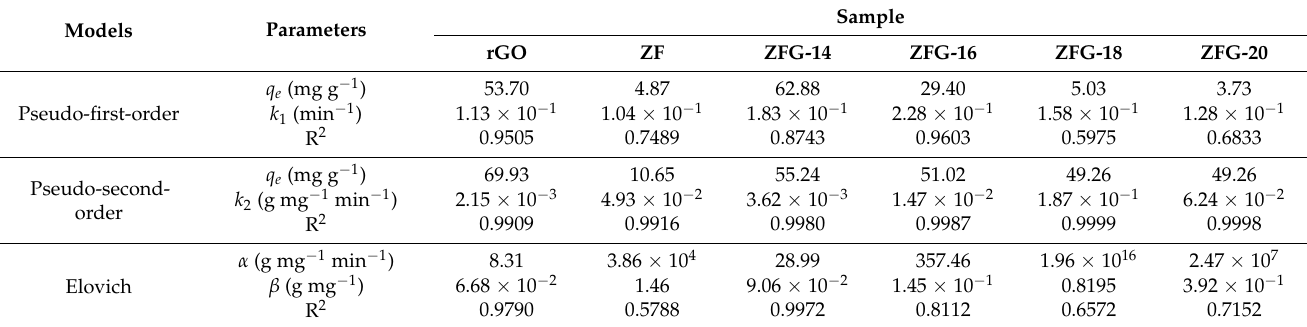
Table 4. Adsorption kinetic parameters of rGO, ZF, and